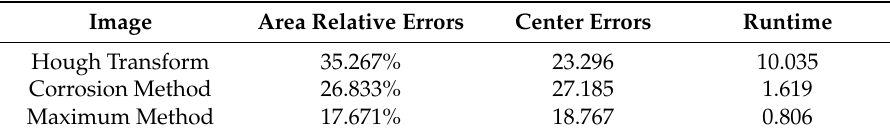
Table 4. Comparison of repeated